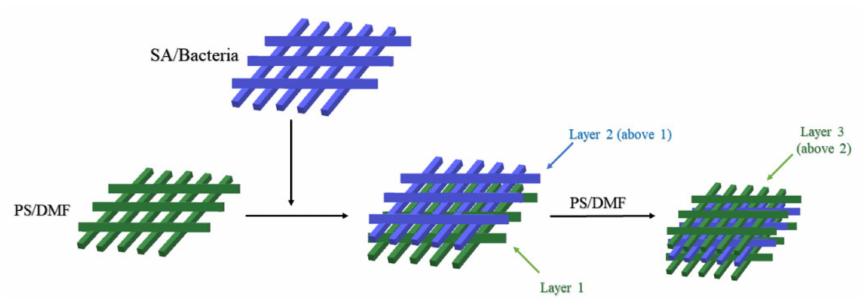
Figure 5. Production of electrospun fibers with encapsulated